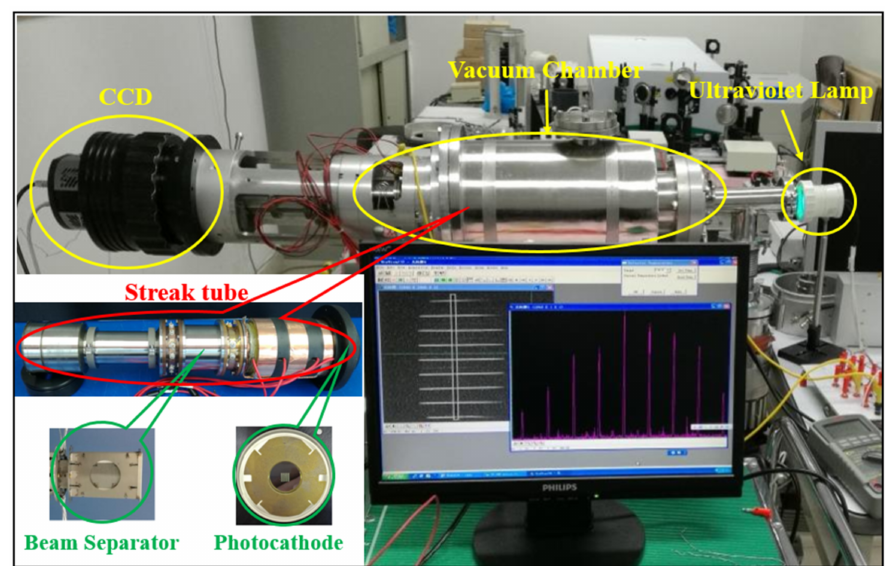
Figure 6. Streak tube and devices used for testing.